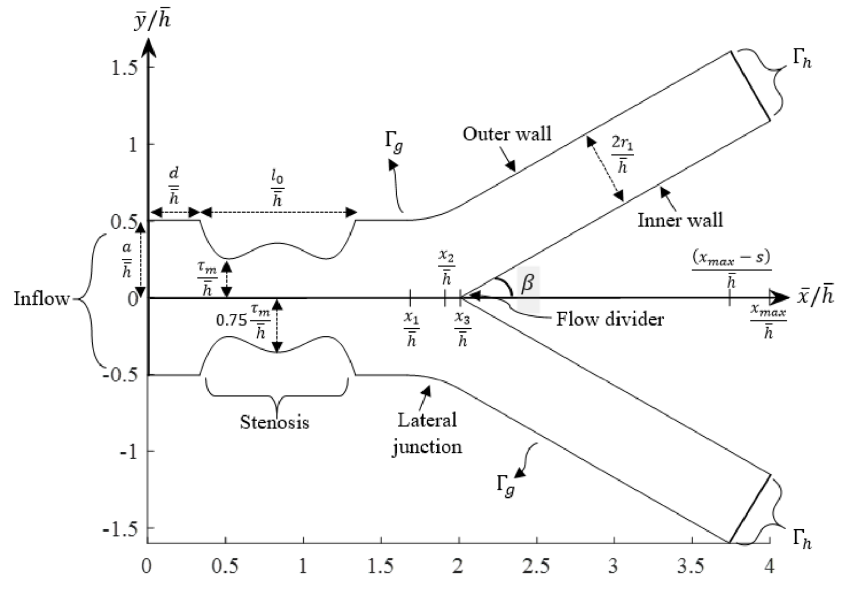
Fig 1. Geometry of the stenosed arterial bifurcation